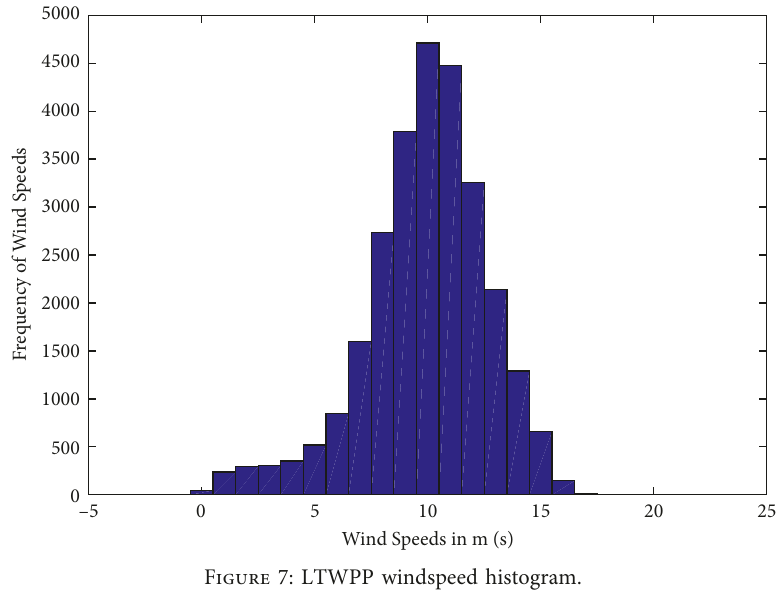
Figure 7: LTWPP windspeed histogram.